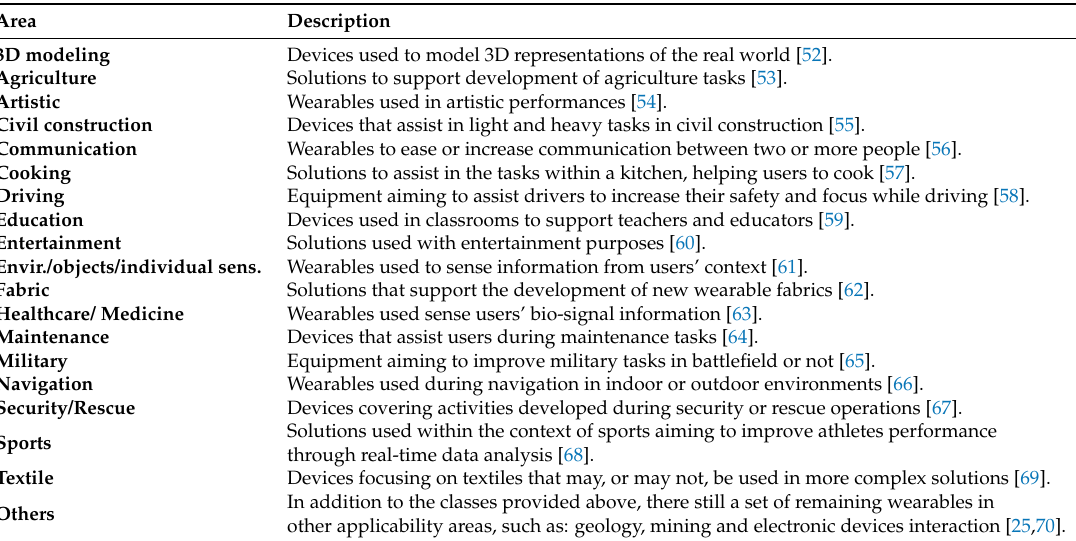
Figure 2. Applicability and common locations where wearable sensors can be positioned. Highlighted points are a few examples of sensors usage. The same hardware can be located in different body parts according to the needs. Table 2. Common applicability areas where wearables are